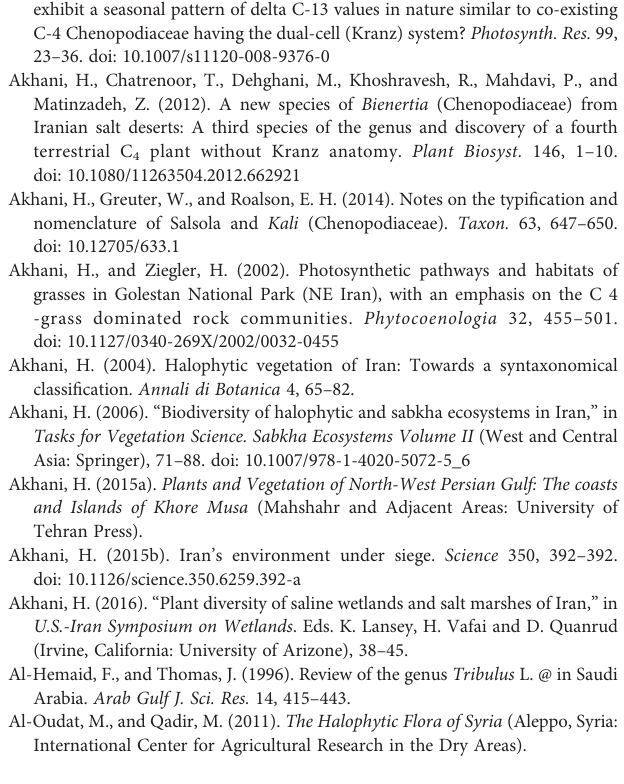
SUPPLEMENTARY DATA SHEET 1 | References of fl oristic